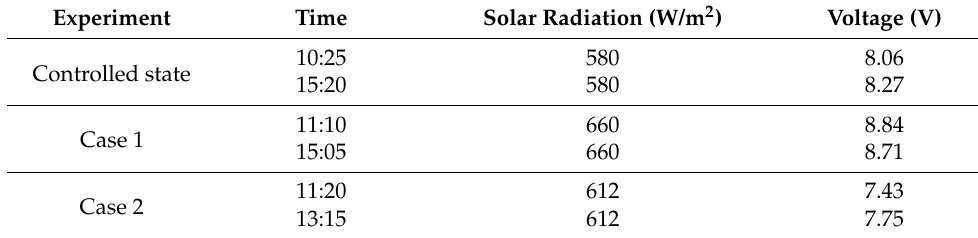
Table 4. Comparison of voltage generated at similar radiation values for three different states.